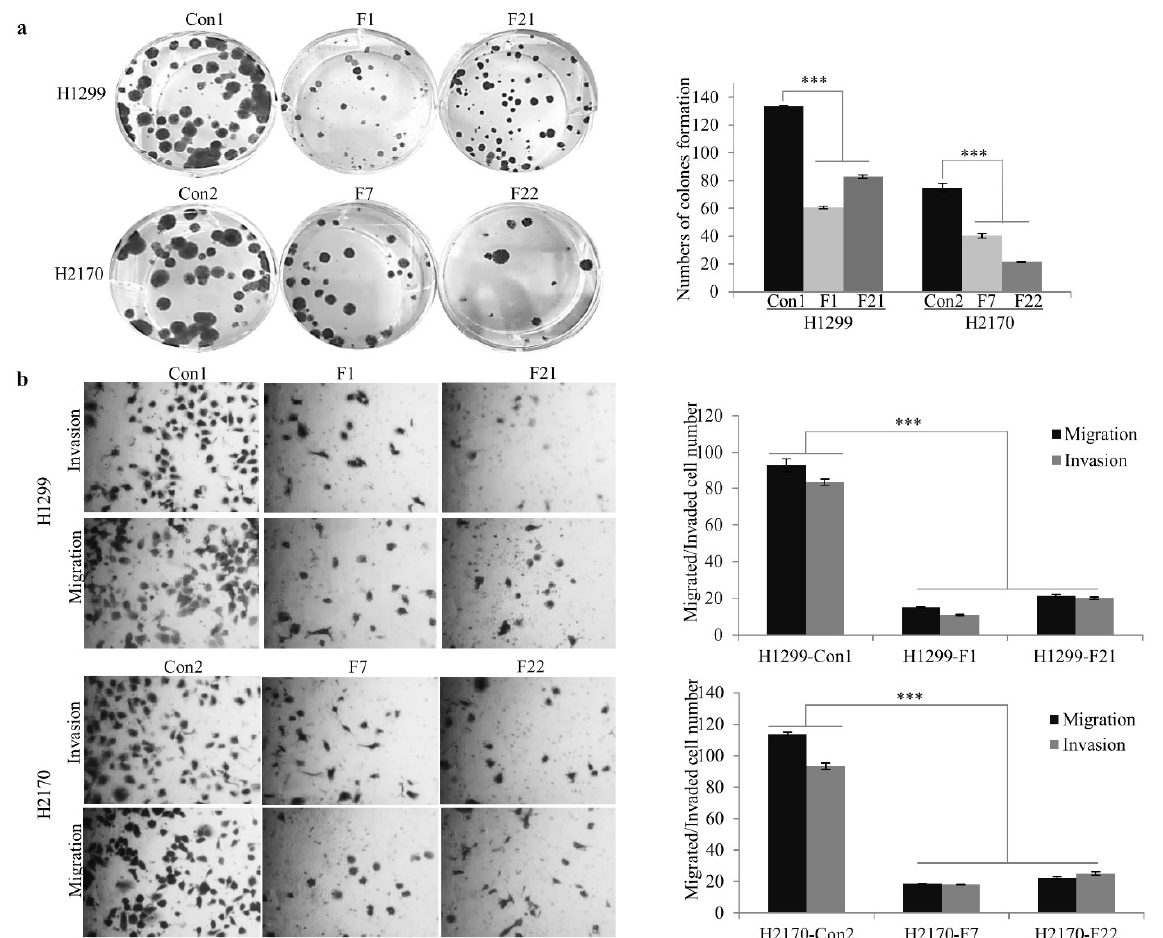
Figure 3. Impact of FBLN2 on NSCLC cell colony formation, migration and invasion. ( a ) Colony formation assay showed that FBLN2 inhibited NSCLC cell proliferation. ( b ) Reduced migration and invasion capabilities by FBLN2 were determined by migration and invasion assays. Left: Representative images of the colony formation, migration and invasion assays. Right: Quantification of the cell numbers of the assays. *** p < 0.001.